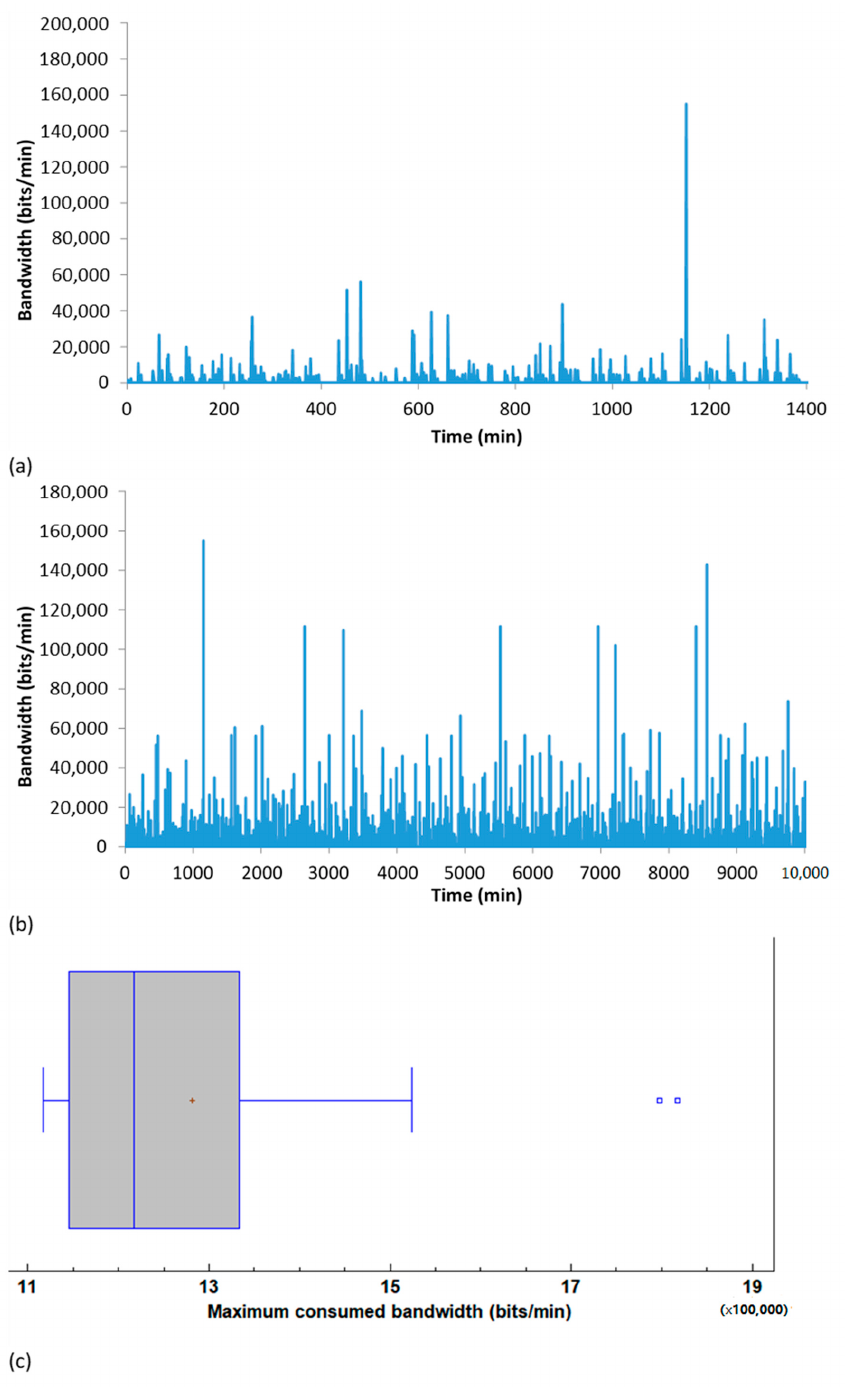
Figure 15. Details of consumed bandwidth in second simulation. Different letters denote different de- 4 tails: ( a ) initial period, ( b ) whole period, ( c ) summary of the maximum bandwidth of 40